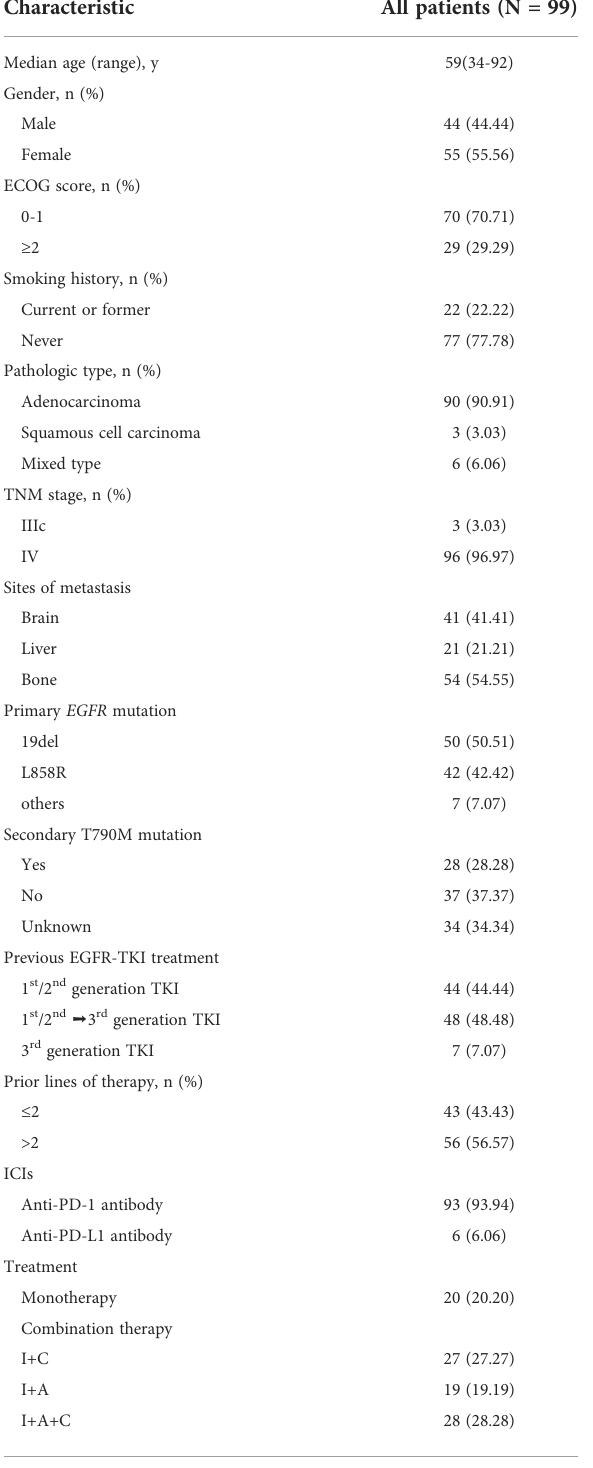
(Figure 2). In the multivariate model, primary EGFR mutation type and treatment mode demonstrated a signi fi cant association with PFS (Figure 4).